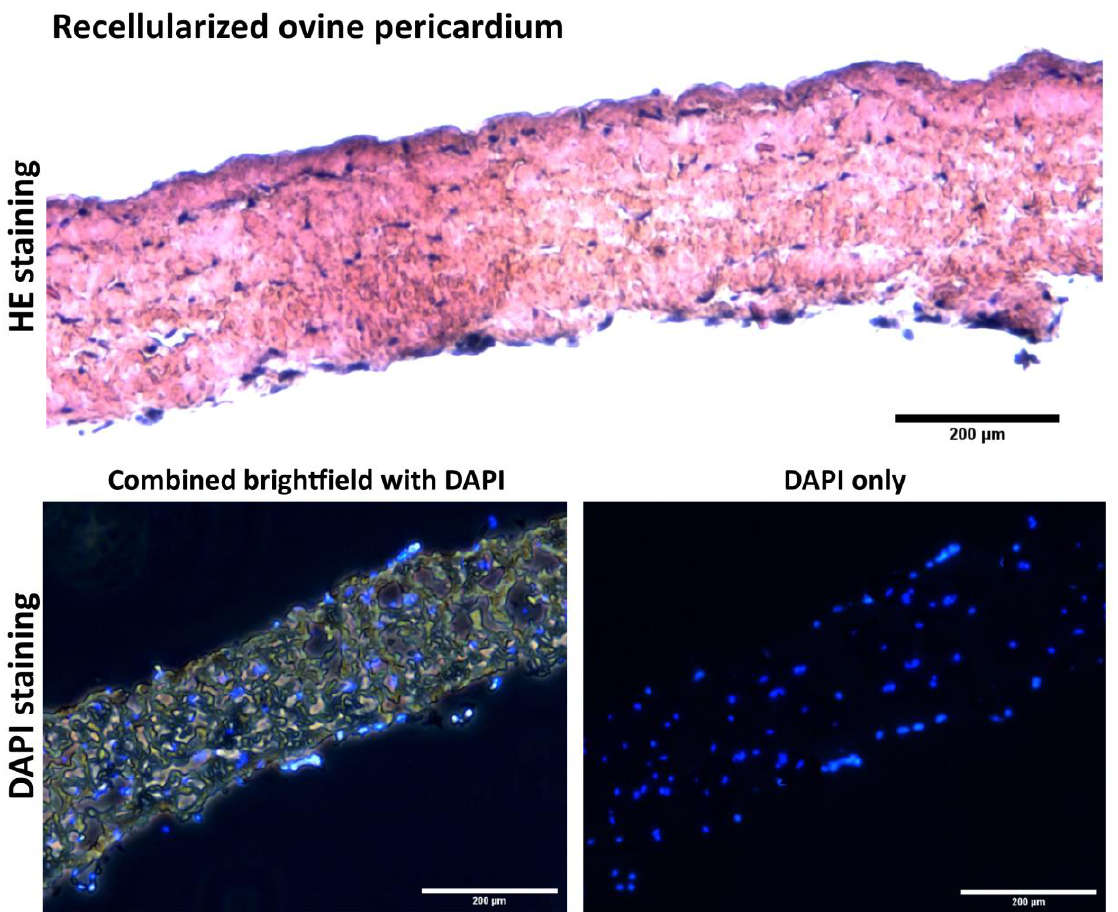
Figure 12. Para ffi n-embedded 20 µ m sections of ovine recellularized pericardium stained with hematoxylin-eosin (HE) and DAPI. Cells were seeded from both sides of the decellularized tissue prior to dynamic stimulation. Cultivation was held for 5 days in a dynamic culture